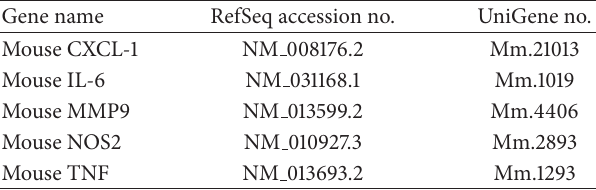
Table 2: Primers used for qRT-PCR of Kupffer